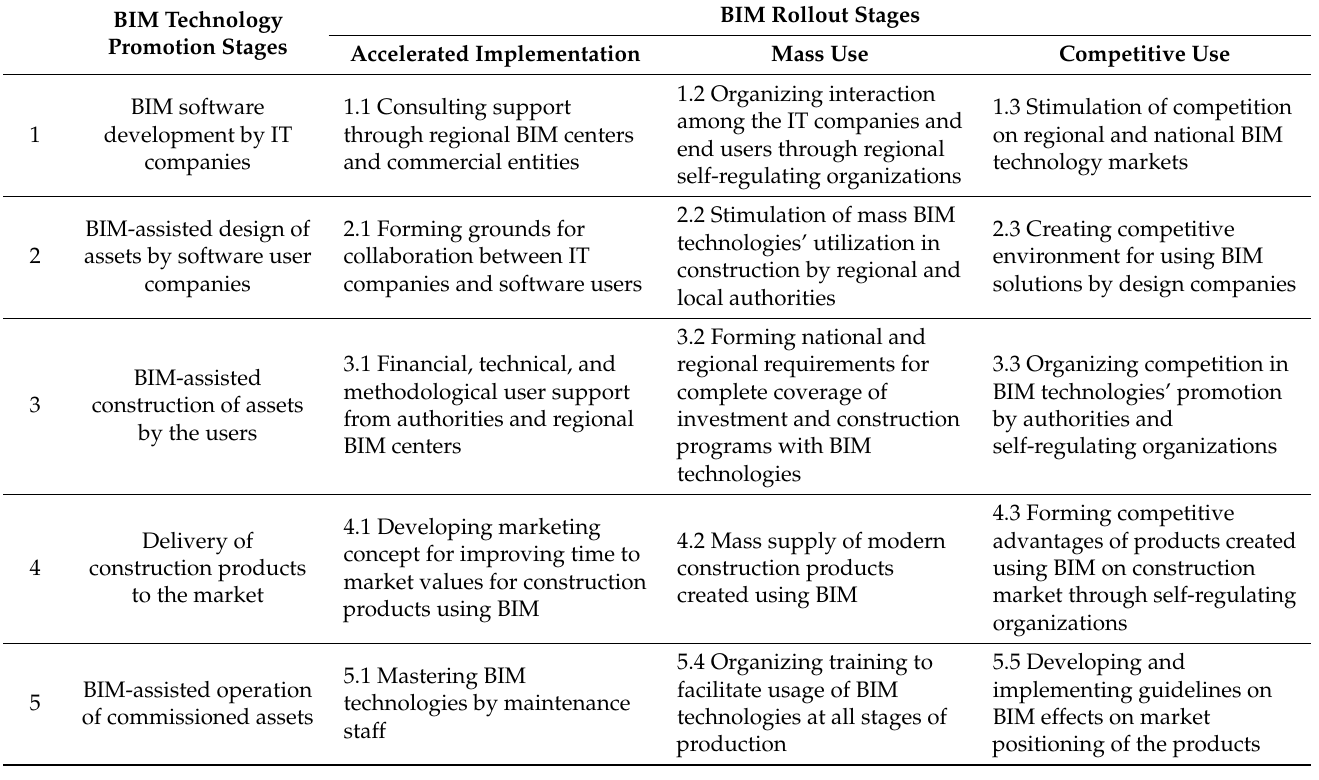
Table 5. Accelerating implementation and use of BIM technologies in the course of BIM rollout and corresponding measures of